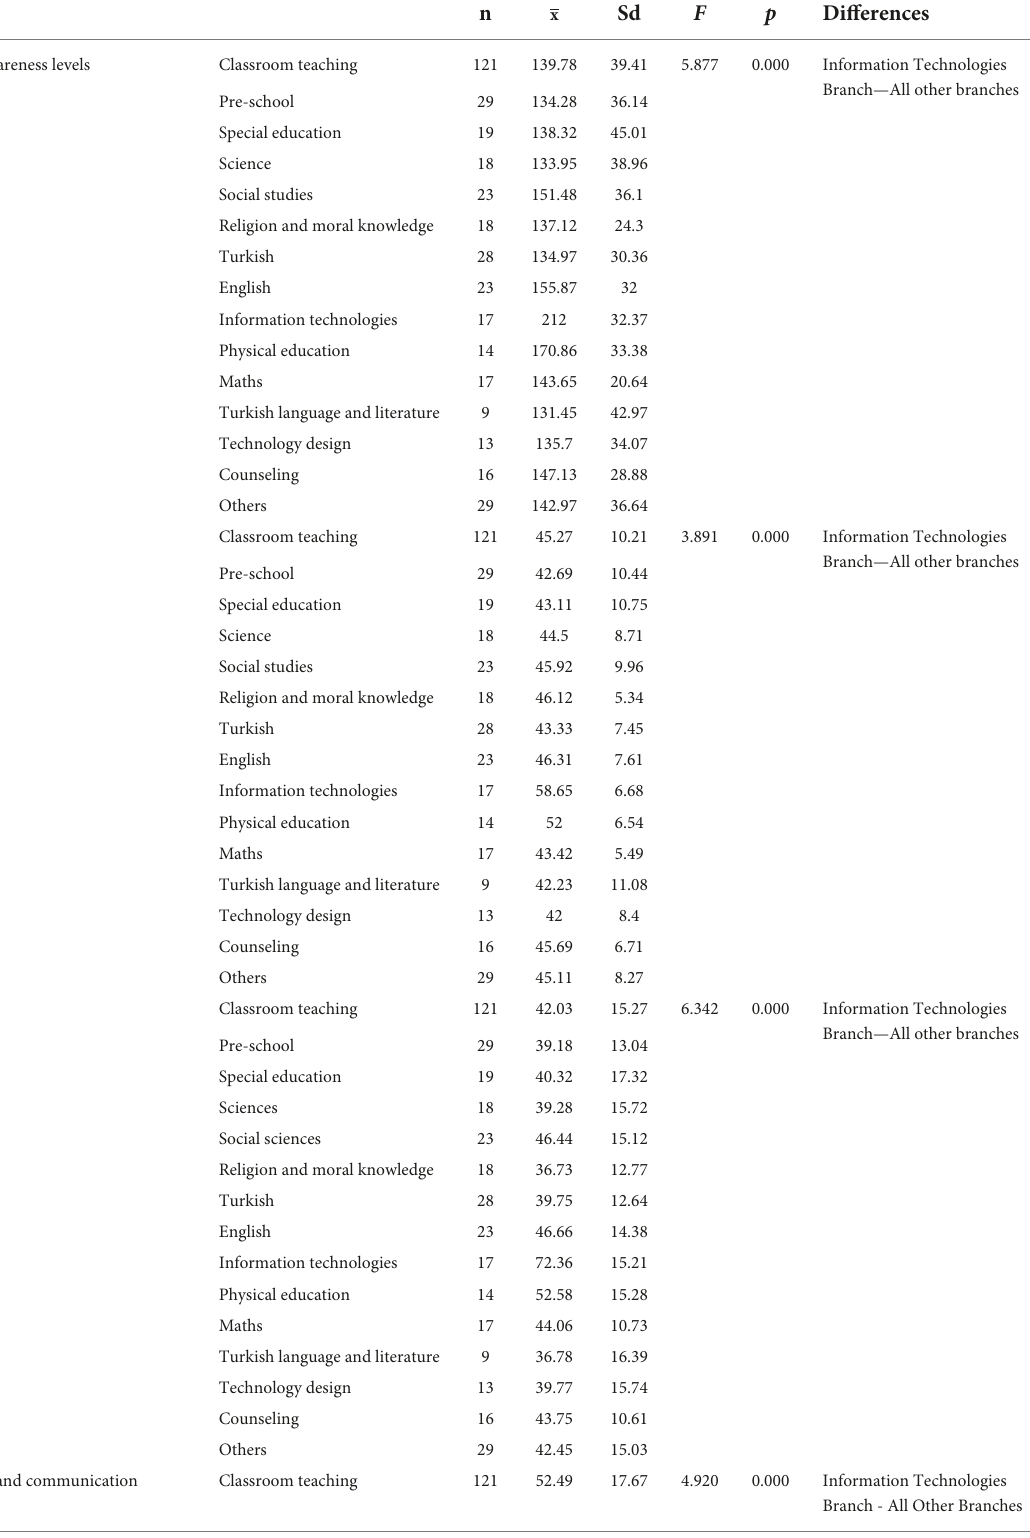
TABLE 5 Teachers’ information security awareness levels and sub-factors relations by